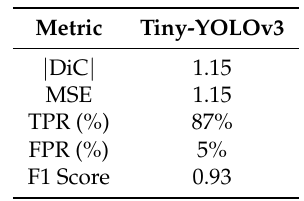
Table 4. Target domain network evaluation